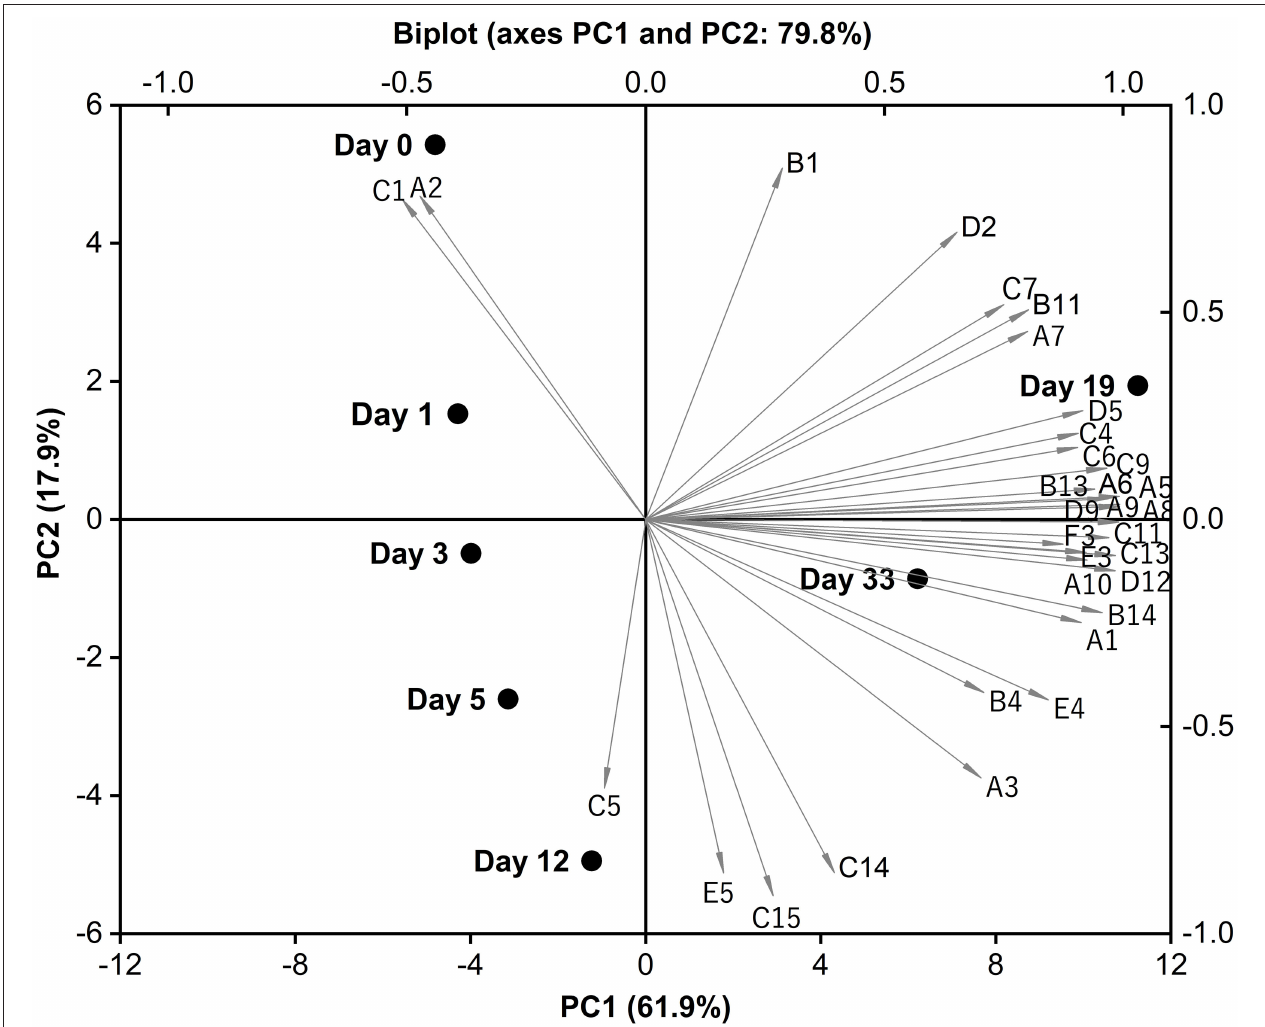
FIGURE 4 | PCA analysis of the volatile profile of Red-Veined Cheese. References: A1 (Acetone), A2 (2,3-Butanedione), A3 (2-Pentanone), A5 (2-Heptanone), A6 (2-Octanone), A7 (Acetoin), A8 (2-Nonanone), A9 (8-Nonen-2-one), A10 (2-Undecanone), B1 (Ethanol), B4 (3-Methyl-1-butanol), B11 (1-Octanol), B13 (Benzyl alcohol), B14 (2-Phenylethanol), C1 (Acetic acid), C4 (Butanoic acid), C5 (2-Methylbutanoic acid), C6 (3-Methylbutanoic acid), C7 (Hexanoic acid), C9 (Octanoic acid), C11 (Decanoic acid), C13 (Dodecanoic acid), C14 (Tetradecanoic acid), C15 (Palmitic acid), D2 (Ethyl butyrate), D5 (Ethyl caproate), D9 (Ethyl octanoate), D12 (Ethyl caprate), E3 (Nonanal), E4 (Benzaldehyde), E5 (Benzeneacetaldehyde), F3 ( δ -Decanolactone).